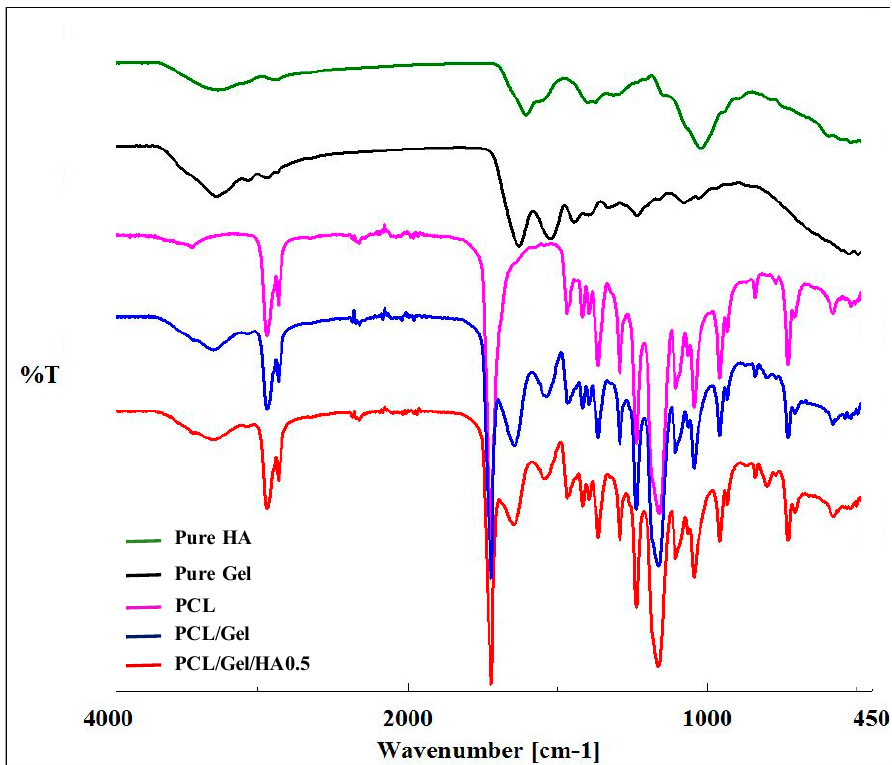
Figure 3. FTIR spectra of HA, Gel, PCL, PCL/Gel, and PCL/Gel/HA scaffolds.